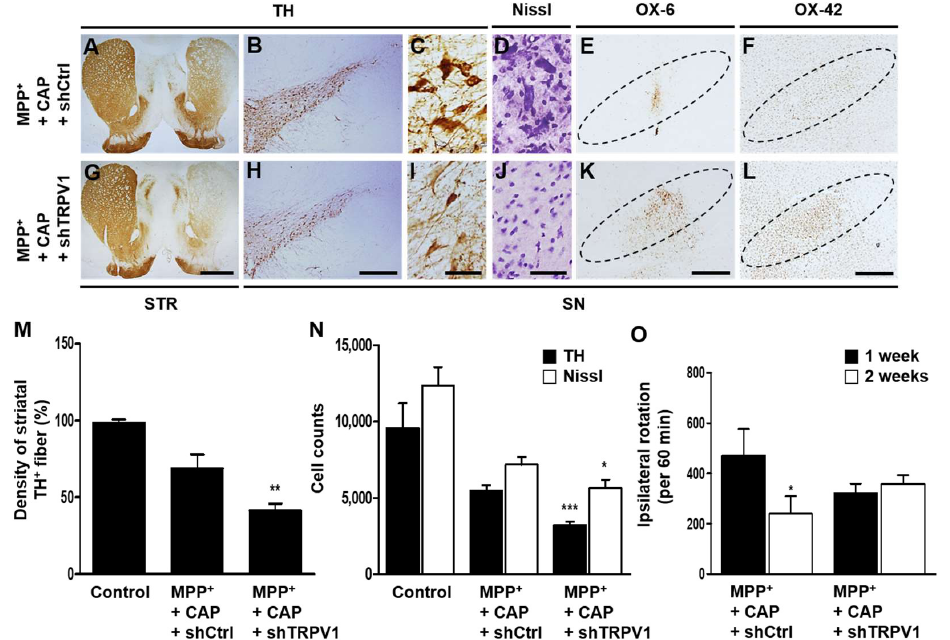
Figure 2. Knockdown of astrocytic TRPV1 induces degeneration on DA neurons and increase of microglial activation in vivo in MPP + -lesioned rat. MPP + was unilaterally injected into the rat MFB followed by injection of shCtrl (control) or shTRPV1 into the SN. All rats i.p. received CAP at 8 days post MPP + injection and a continuous single injection per day for 7 days. Rats were transcardially perfused after the last amphetamine-induced rotation experiment. ( A – L ) Photomicrographs of TH + fibers ( A , G ) in the STR, and TH + ( B , C , H , I ), Nissl + ( D , J ), OX-6 + ( E , K ) and OX-42 + ( F , L ) cells in the SN.